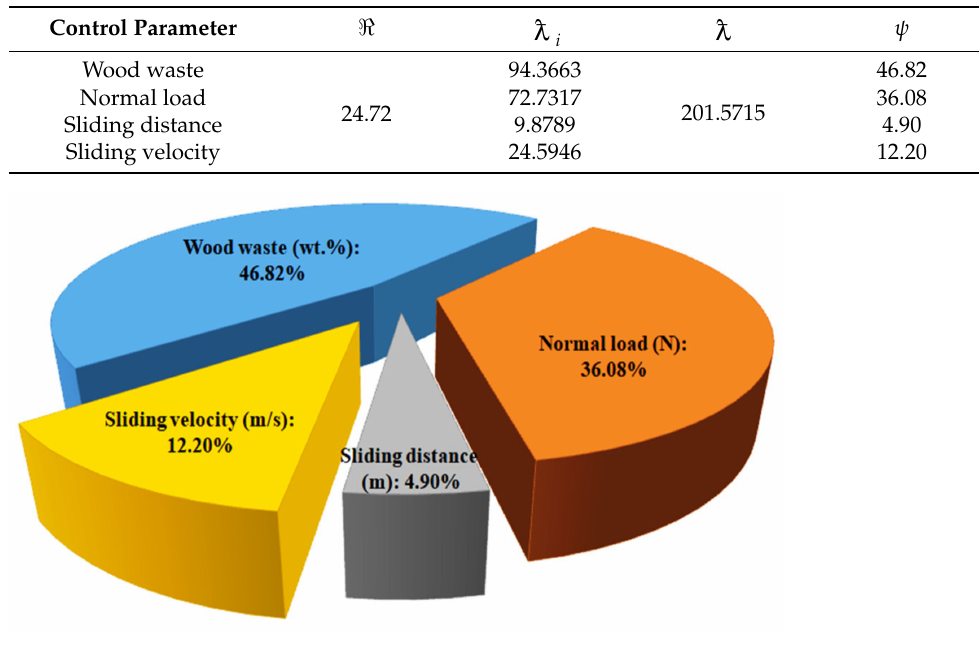
Figure 7. Contribution ratio of each control parameter to volumetric